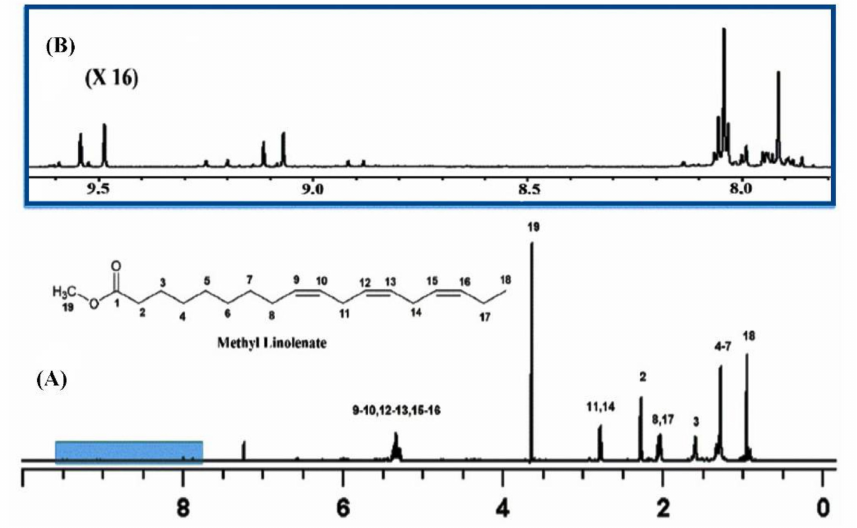
Figure 42. ( A ) 800 MHz 1 H-NMR spectrum of 20 mg methyl linolenate in CDCl 3 subjected to heating at 40 ◦ C for 48 h. Number of scans = 64, acquisition time = 1.02 s, experimental time = 6.5 min, relaxation delay = 5 s, T = 298 K; ( B ) selected region of the C-O-O-H resonances of its primary oxidation products